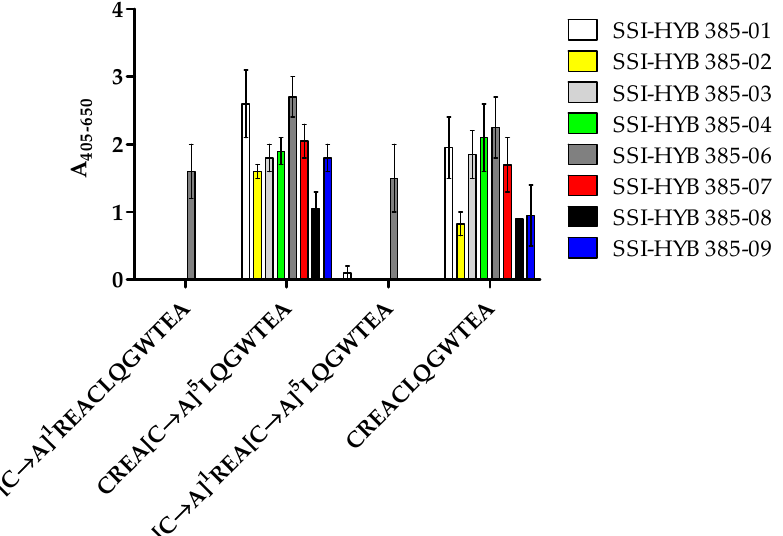
Figure 6. Reactivity of SSI-HYBs to Ala-substituted peptides analysed by modified enzyme-linked immunosorbent assay. The control peptide CREACLQGWTEA was used for generation of substituted peptides where Cys 1 and Cys 5 were substituted with Ala, and a single peptide where both Cys residues were substituted with Ala. Absorbances were corrected for background reactivity by subtracting reactivity from non-coated wells.